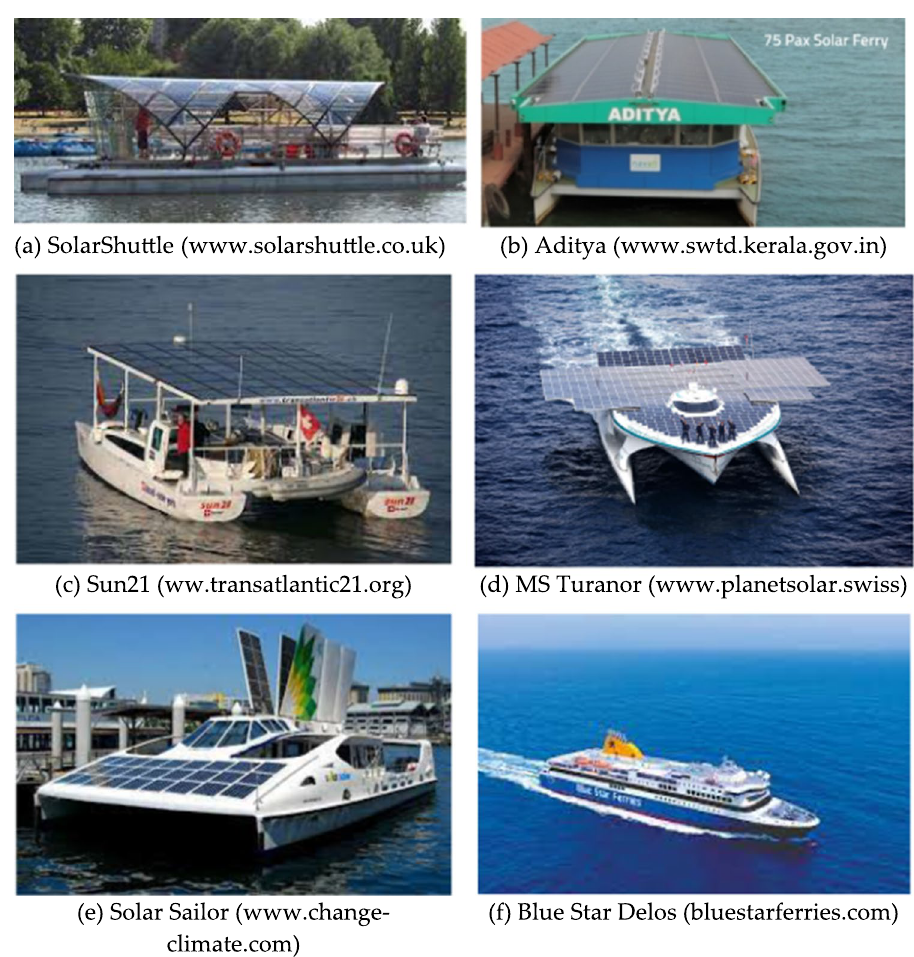
Fig. 10 Examples of solar- powered vessel. a SolarShuttle (www. solar shutt le. co. uk). b Aditya (www. swtd. kerala. gov. in). c Sun21 (ww.transat- lantic21.org). d MS Turanor (www. plane tsolar. swiss). e Solar Sailor (www. change- clima te. com). f Blue Star Delos